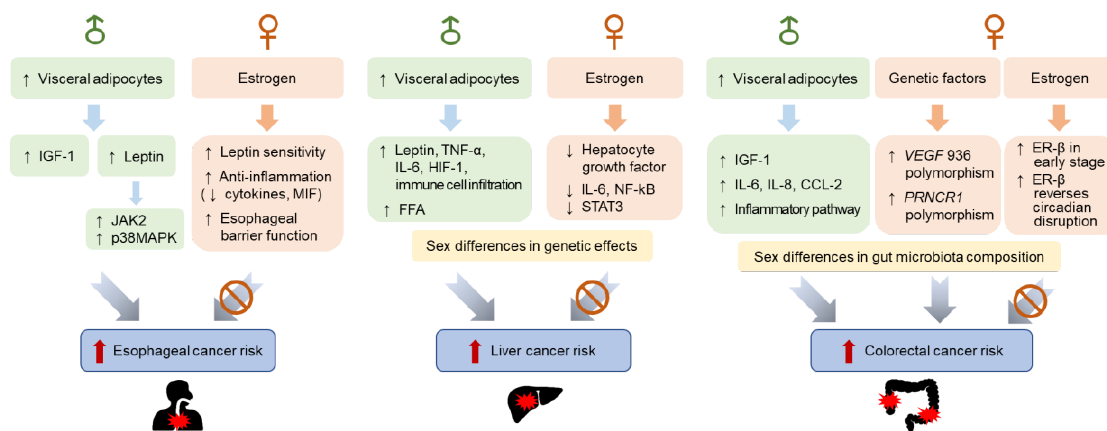
Figure 2. Sex differences in the incidence of major gastrointestinal cancers associated with obesity. Men and women exhibit differences in body fat distribution and energy homeostasis regulation. Overall, visceral adipose tissue, more abundant in men than in women, is positively associated with the incidence of esophageal, liver, and colorectal cancers. These sex disparities are partly explained by the availability of estrogens and other genetic factors regulating inflammation, cell growth, and apoptosis. Sex differences in gut microbiota composition may contribute to differences in the incidence and phenotype of colorectal cancer. CCL2, chemokine (C-C motif) ligand 2; ER-β, estrogen receptor β; FFA, free fatty acid; HIF-1, hypoxia-inducible factor 1; IGF-1, insulin-like growth factor 1; IL-6, interleukin 6; IL-8, interleukin 8; JAK2, janus kinase 2; MIF, macrophage migration inhibitory factor; NF-κB, nuclear factor kappa-light-chain-enhancer of activated B cells; p38MAPK, p38 mitogen-activated protein kinases; PRNCR1, lncRNA prostate cancer non-coding RNA; STAT3, sig-